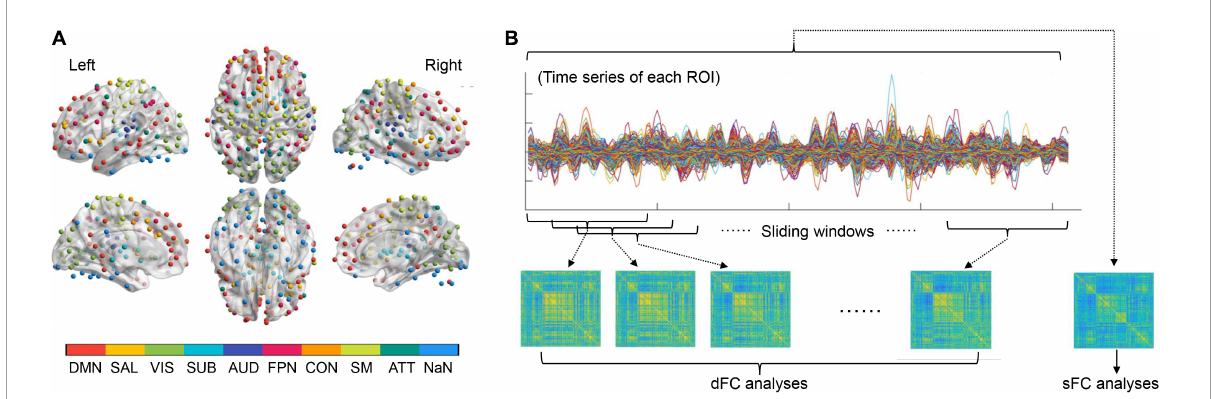
FIGURE1 (A) The regions of interests (ROIs) used to define the brain nodes and their subnetwork assignments. (B) A summary of procedures for static functional connectivity (sFC) and dynamic functional connectivity (dFC) analyses (see details in the Methods section). ATT, attention subnetwork; AUD, auditory subnetwork; CON, cinguloopercular subnetwork; DMN, default-mode subnetwork; FPN, frontoparietal subnetwork; NaN, unassigned; SAL, salience subnetwork; SM, sensorimotor subnetwork; SUB, subcortical subnetwork; VIS, visual